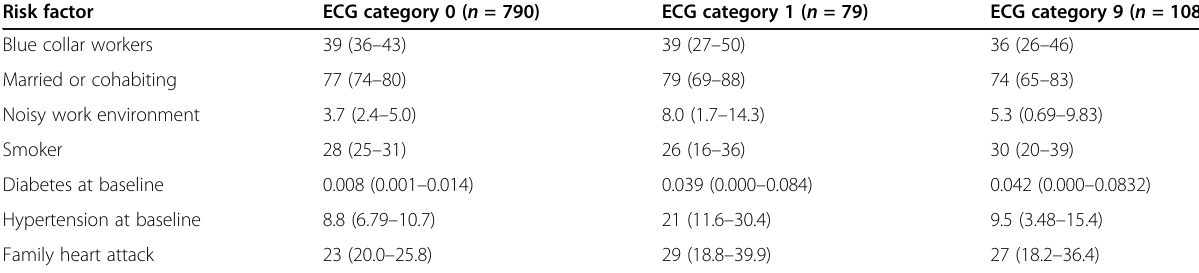
Table 5 Estimated percentages of “ yes ” response, with confidence intervals in brackets for dichotomous risk factors by ECG category